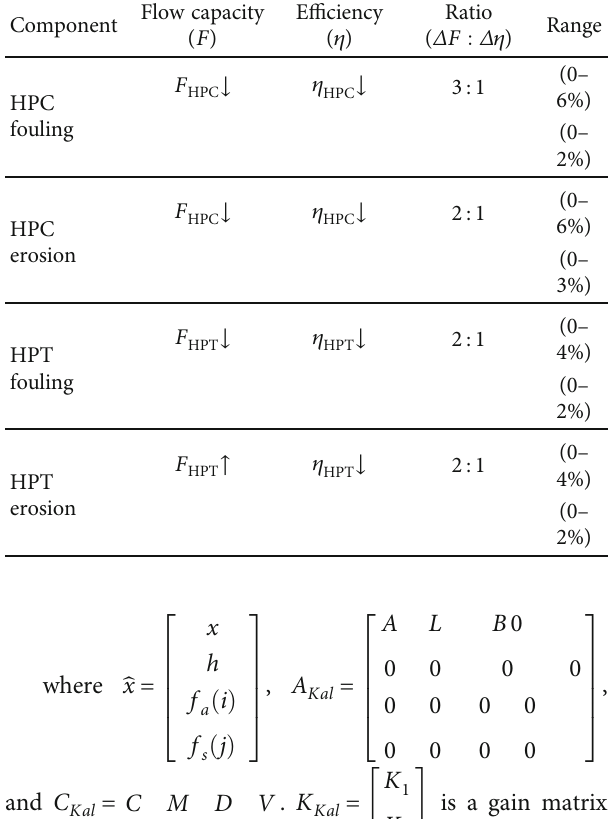
Table 1: Components health parameter degradation. Flow capacity Component ( F